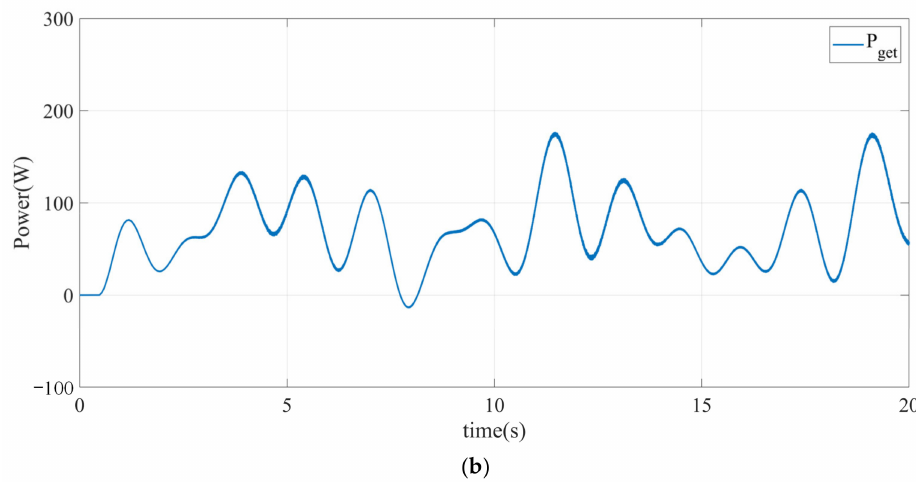
Figure 14. Electrical and mechanical dynamic response: ( a ) Q -axis current of generator; ( b ) power capture in